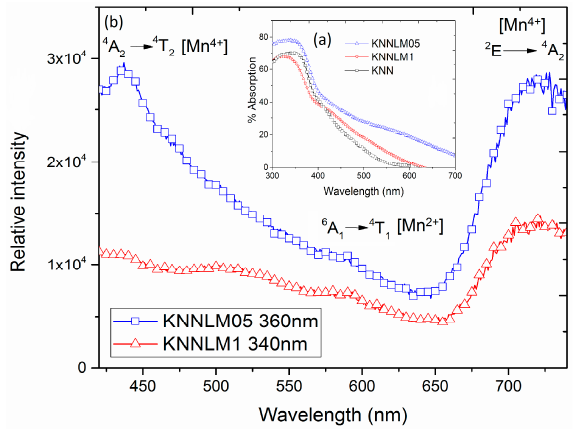
Figure 7. Absorption edge ( a ) and emission spectra; ( b ) for KNNLM05 and KNNLM1 compounds.